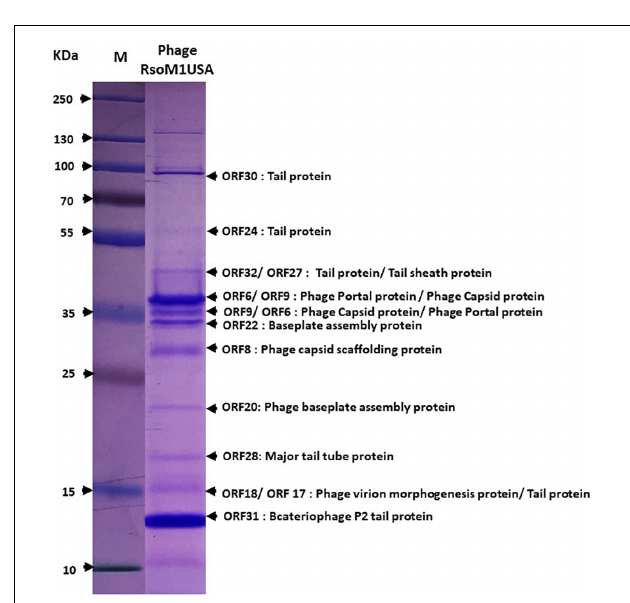
FIGURE 3 | Expression of structural proteins of Ralstonia phage RsoM1USA. Proteins from purified phage virions were separated by SDS-PAGE gel (14%) and stained with Coomassie blue. The functions of the 11 protein bands predicted to correspond to ORFs 6, 8, 9, 17, 18, 20, 22, 24, 28, 30, 31, and 32 were indicated. M: protein ladder, with its molecular weight in kilodaltons (kDa) indicated on the